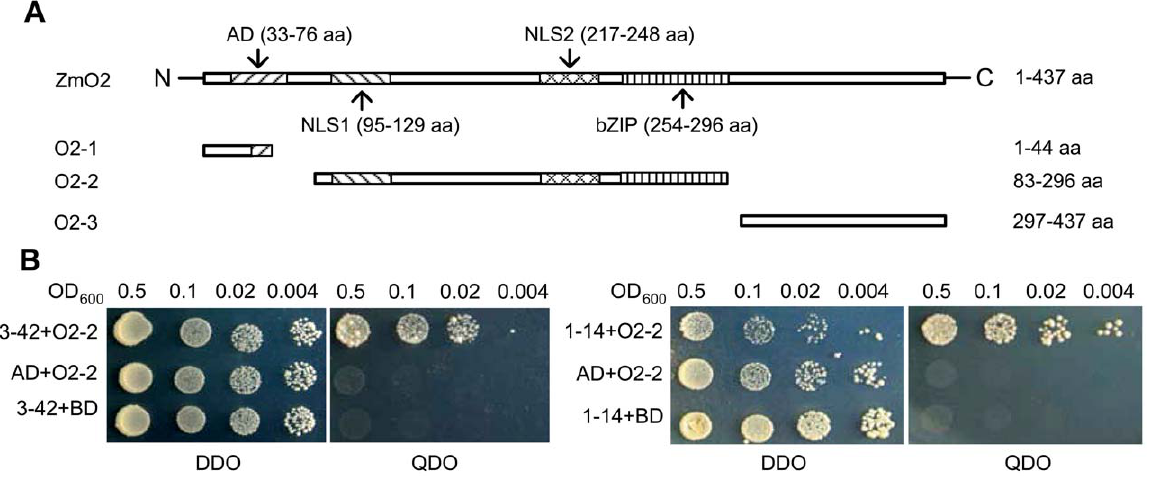
Figure 1. Baits construction and positive clones validation. ( A ) Structure of ZmO2 and three truncated versions of ZmO2 (O2-1, O2-2 and O2- 3) [42]. AD: acidic activation domain; bZIP: basic leucine zipper domain; NLS: nuclear localisation signals. ( B ) Yeast two-hybrid analysis of the interaction between O2-2 and 3–42, and O2-2 and 1–14. Clones 3–42 and 1–14 are two of the five positive Taxilin clones (Table 1). AD is the GAL4 activation domain, and BD is the GAL4 DNA binding domain. 3–42 + O2-2 (or 1–14 + O2-2) represents the prey protein 3–42 (or 1–14) are co-expressed with the bait protein O2-2 in yeast cells. AD + O2-2 represents only AD domain without prey protein is co-expressed with the bait protein O2-2. 3– 42 + BD (or 1–14 + BD) represents the prey protein 3–42 (or 1–14) is co-expressed with BD domain without bait protein. Yeast cells were cultured on DDO selective media (SD/ 2 Leu/ 2 Trp) and QDO (SD/ 2 Ade/ 2 His/ 2 Leu/ 2 Trp) in a dilution series indicated by the OD 600 values displayed above the